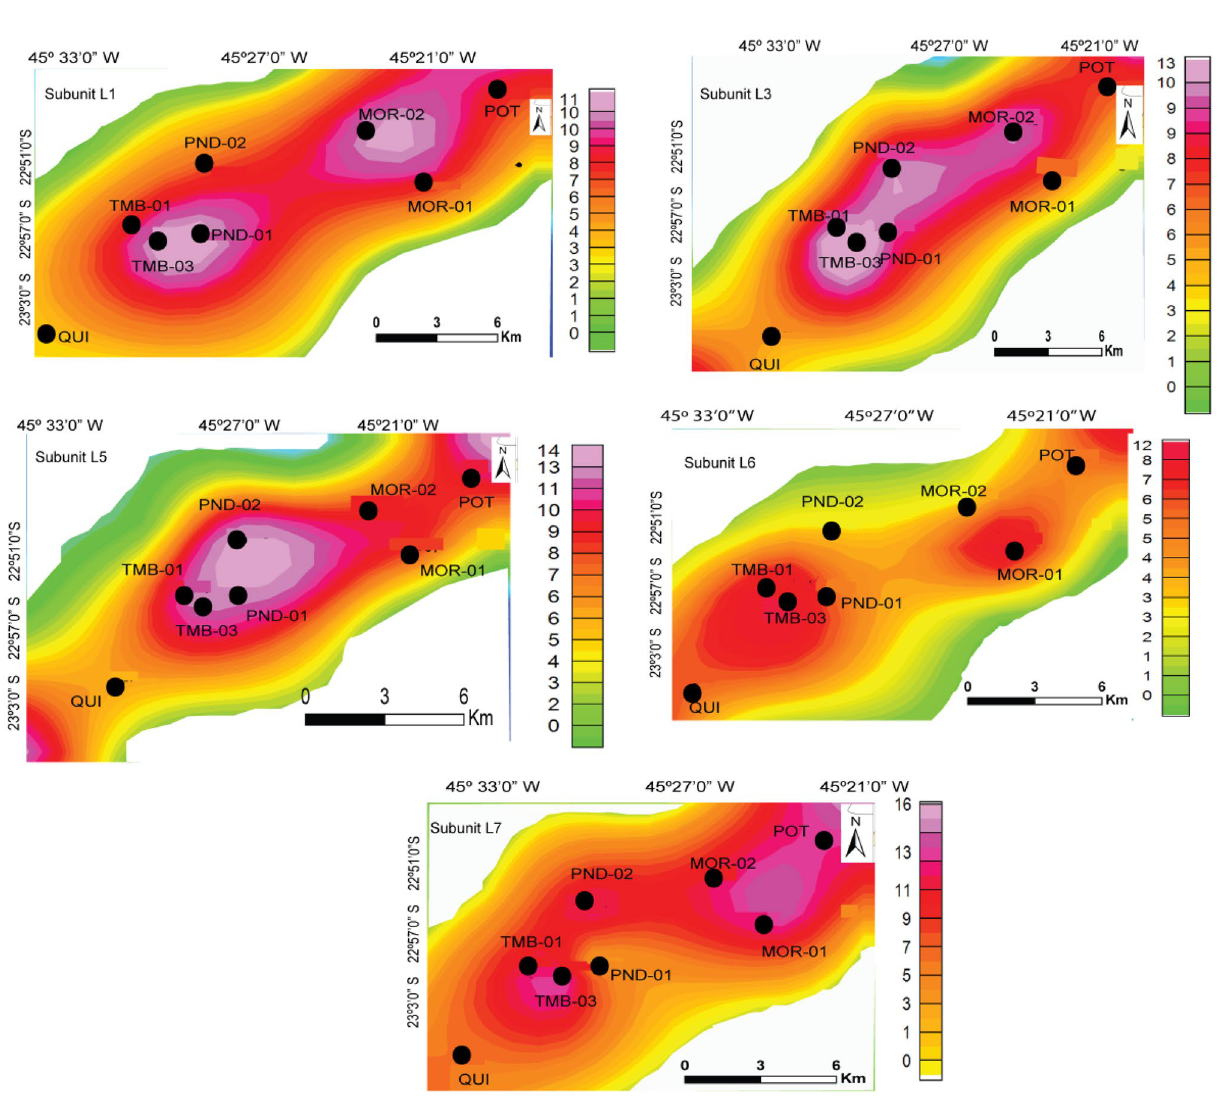
Fig. 7 Map showing the regions (wells) that are richest in TOC, for each